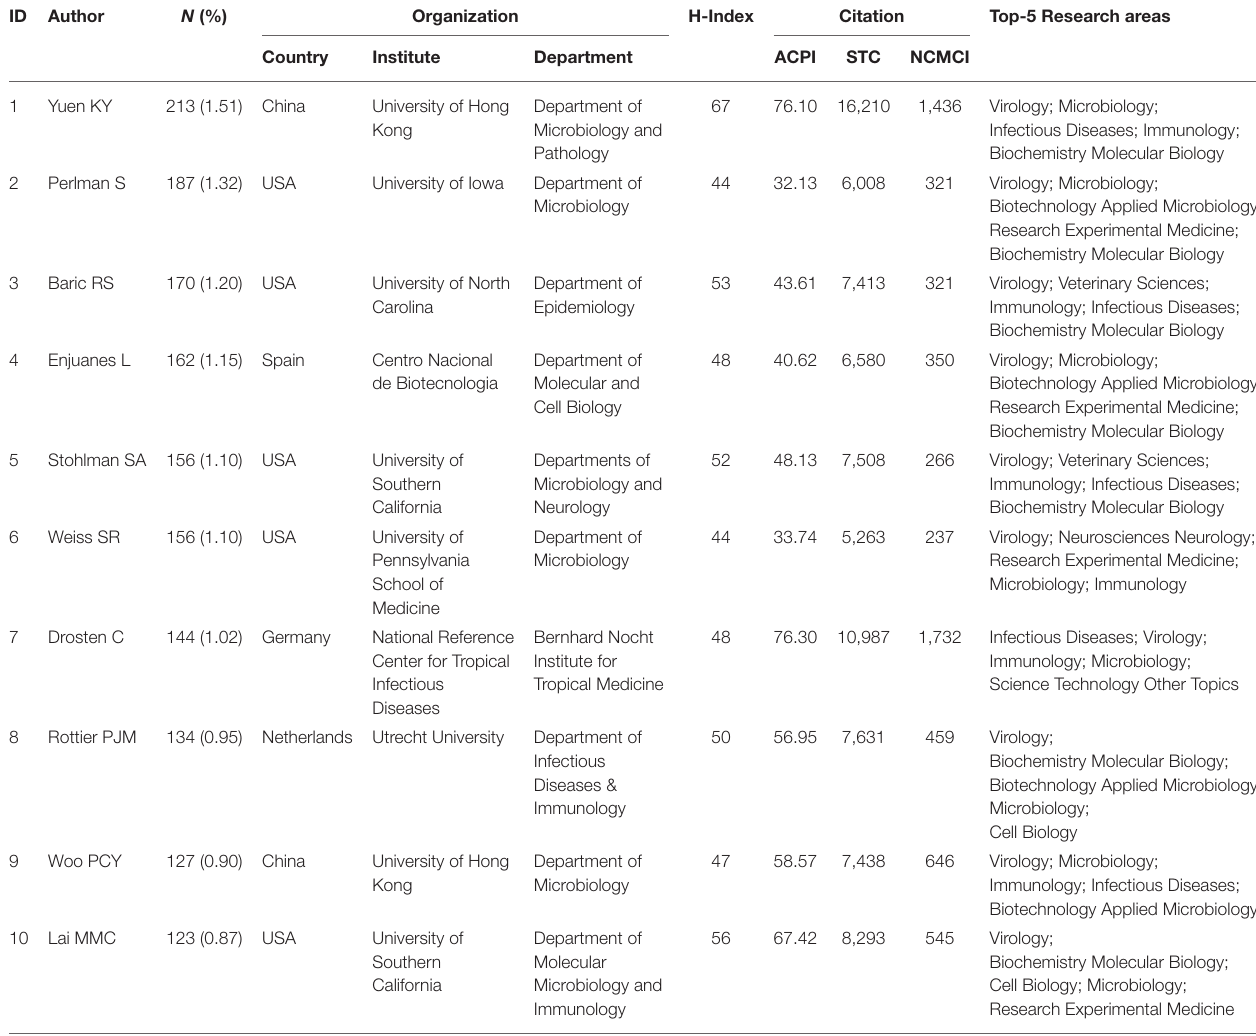
TABLE 2 | Characteristics of the top-10